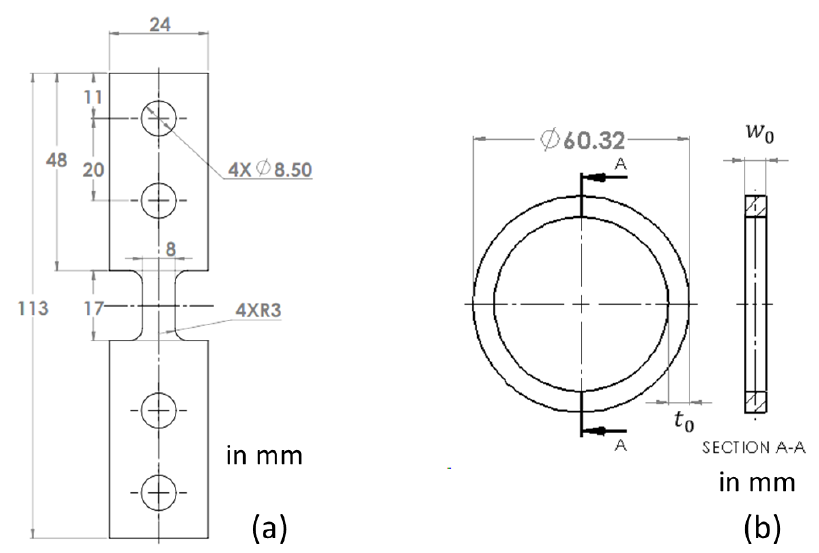
Figure 1. Dimensions of specimens used in the study: ( a ) dog-bone specimen and ( b ) pipe ring spec- imen.